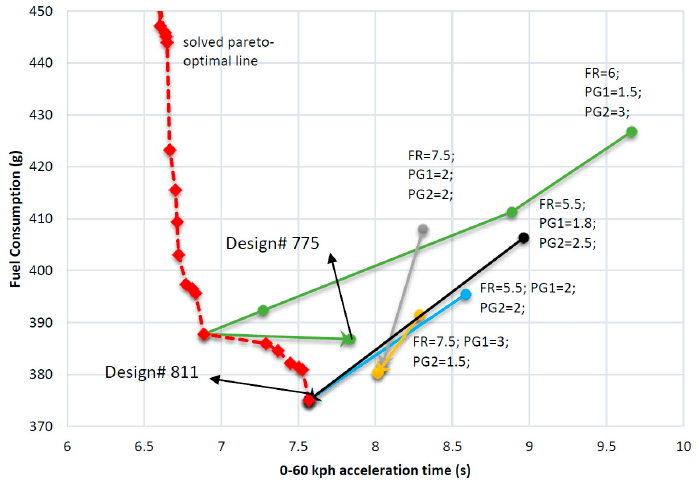
Figure 10. Sample results from iterative optimization.